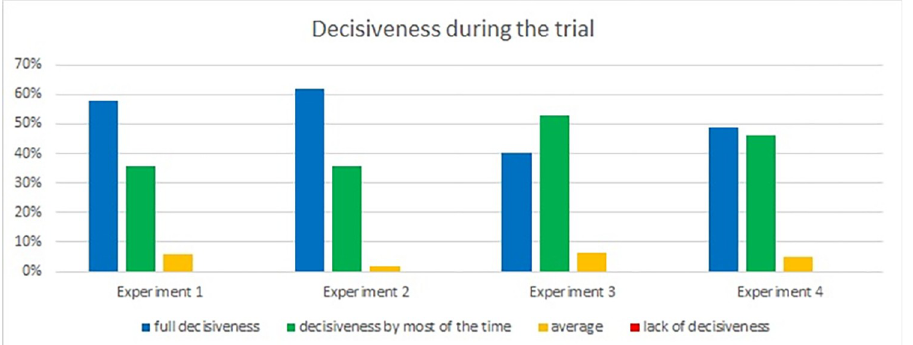
Fig 19. Decisiveness rating—question 10. (Results from the Laliki experiment are on the left; results from Gda ń sk on the right).